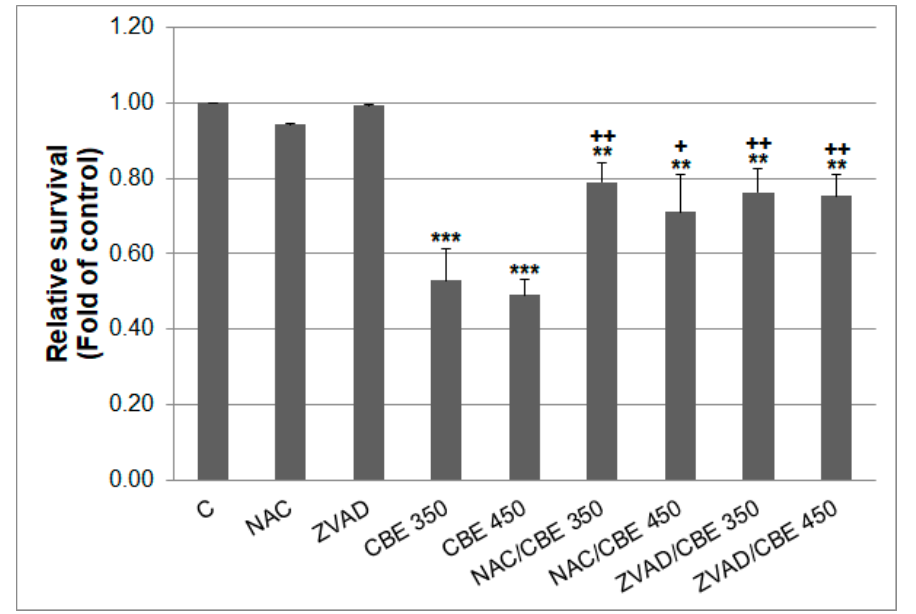
Figure 1. MCF-7 cells proliferation after CBE or NAC/CBE or ZVAD/CBE combination treatment. Data were obtained from three independent measurements. Significantly different ** p < 0.01, *** p < 0.001 vs. untreated cells (control) and + p < 0.05, ++ p < 0.01 vs. CBE treatment.